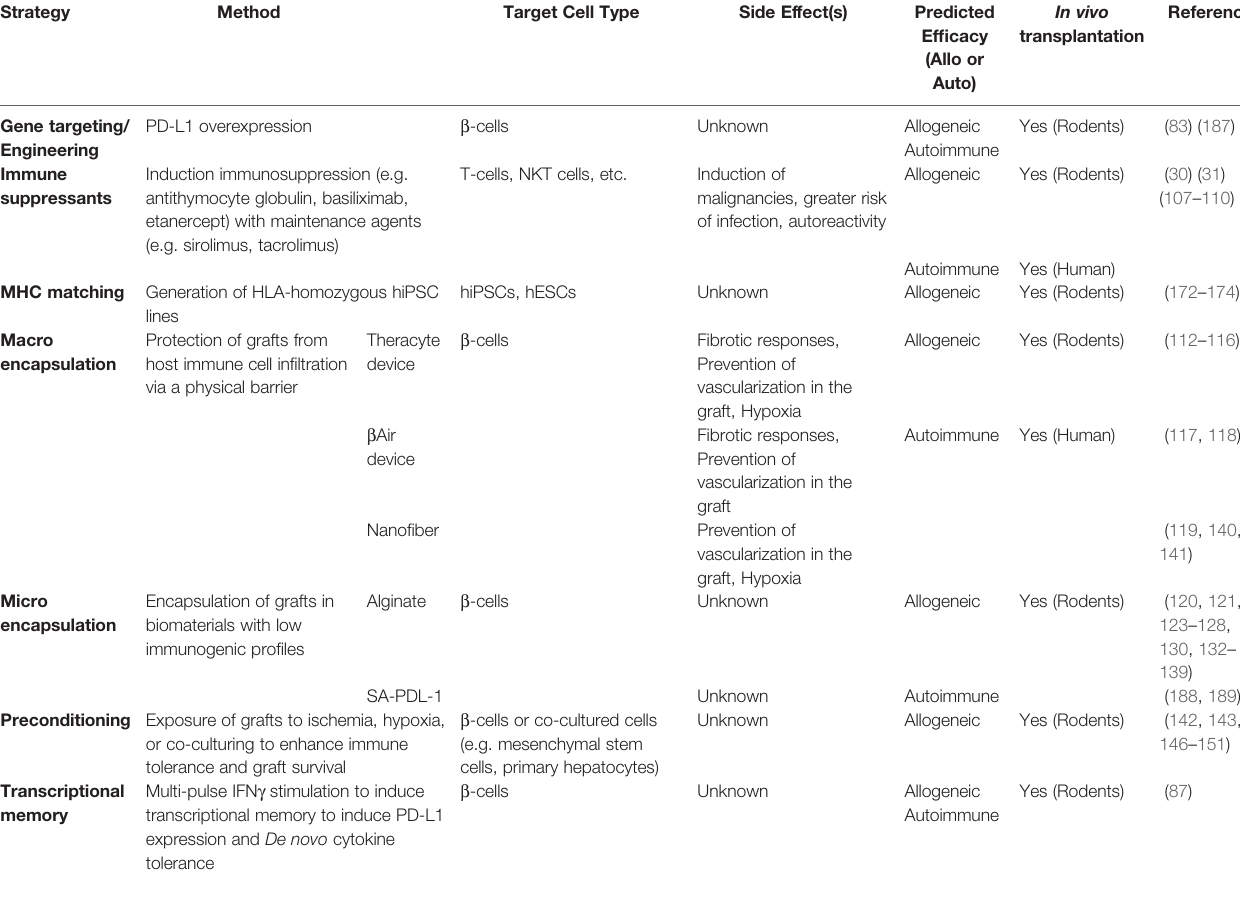
TABLE 1 | Summary of immune protection studies for stem cell-derived islets or primary